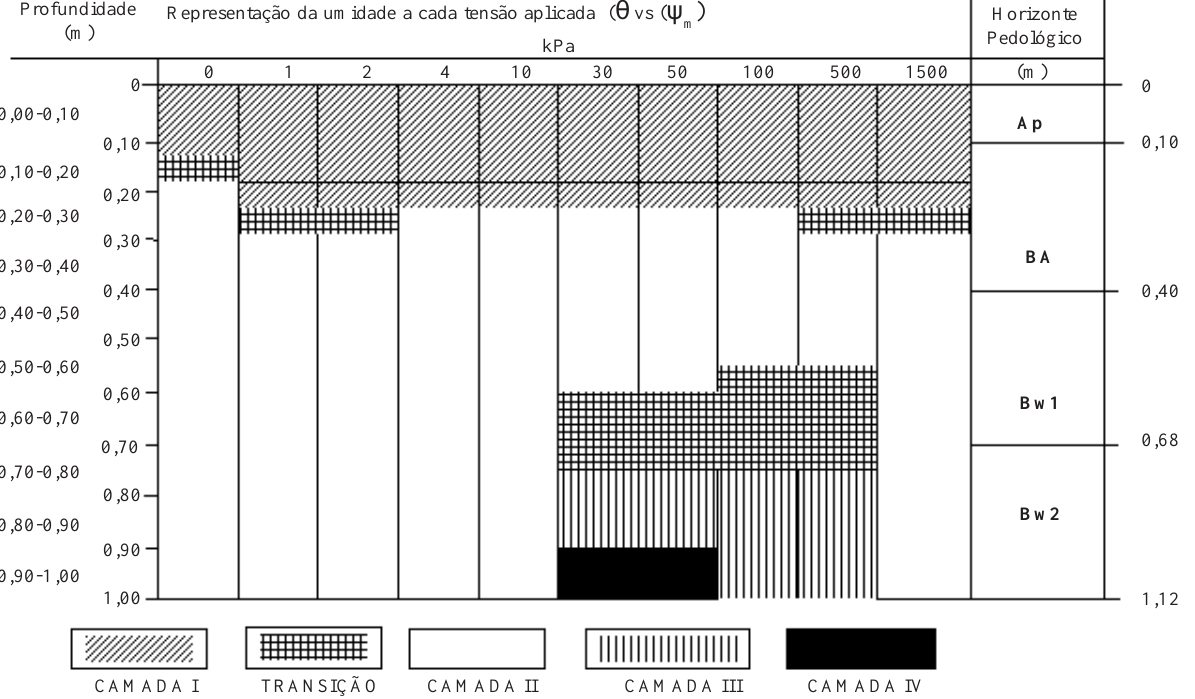
Figura 4. Diagrama comparativo entre horizontes hidráulicos e pedológico identificados no Latossolo Vermelho distroférrico